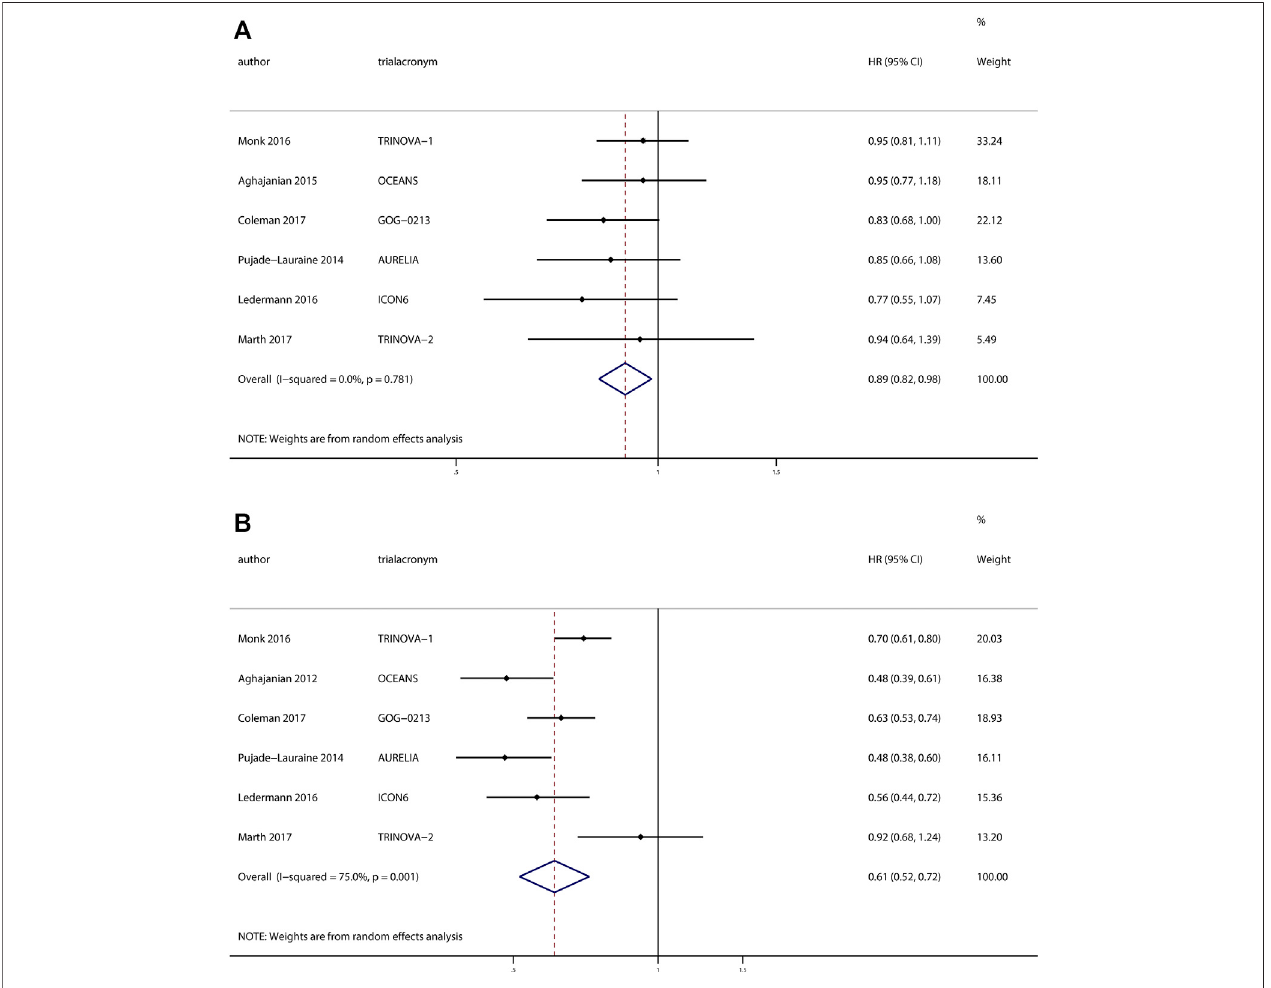
FIGURE 4 | Anti-angiogenesis maintenance treatment vs placebo in relapsed ovarian cancer. (A) Overall survival (OS). (B) Progression-free survival (PFS).